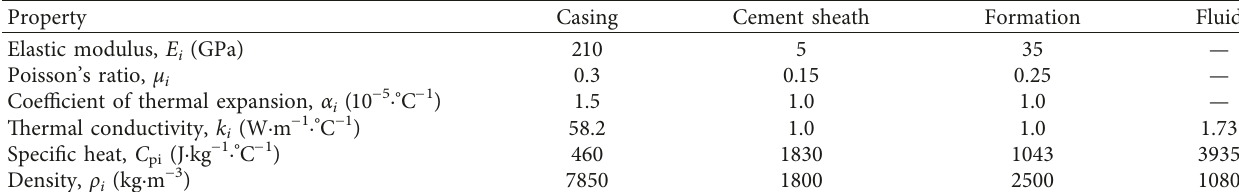
Table 1: Thermal and mechanical Parameters of fluid-casing-cement sheath-formation system.